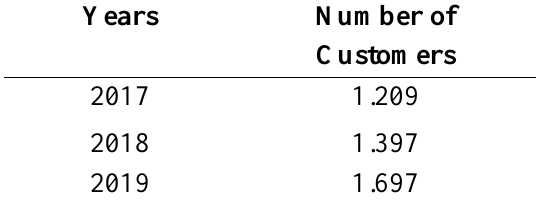
Tabel 2. Number of Customers Tabungan Faedah BRI Syariah